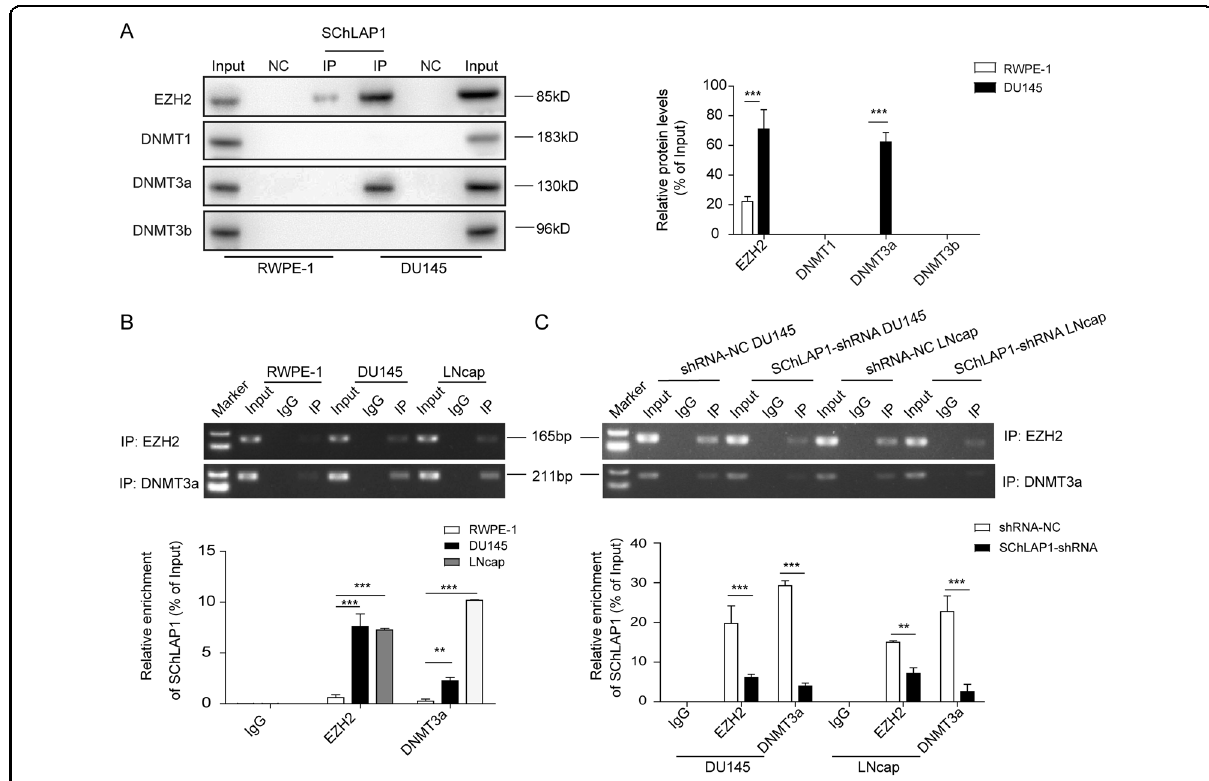
Fig. 2 By interaction with EZH2, SChLAP1 repressed multiple miRNA expression on chromosome 5 including the miR-340-3p in prostate cancer cells. A RNA pull-down combined with western blotting analysis by lncRNA SChLAP1 probe for the interaction with EZH2 or DNMTs (DNMT1, DNMT3a, and DNMT3b) in RWPE-1 and DU145 cells. Negative control (NC): antisense RNA probe, IP: immunoprecipitation. B RIP assay combined with RT-qPCR analysis by EZH2 antibody to validate direct interaction between EZH2 and SChLAP1 in RWPE-1, DU145, and LNcap cells. C RIP assay combined with RT-qPCR analysis by EZH2 antibody for the binding to SChLAP1 in DU145 and LNcap cells with SChLAP1 knockdown. The results are presented as the mean ± SD. ** P < 0.01, *** P < 0.001. SChLAP1 second chromosome locus associated with prostate-1, EZH2 Enhancer of Zeste Homolog 2, DNMT DNA